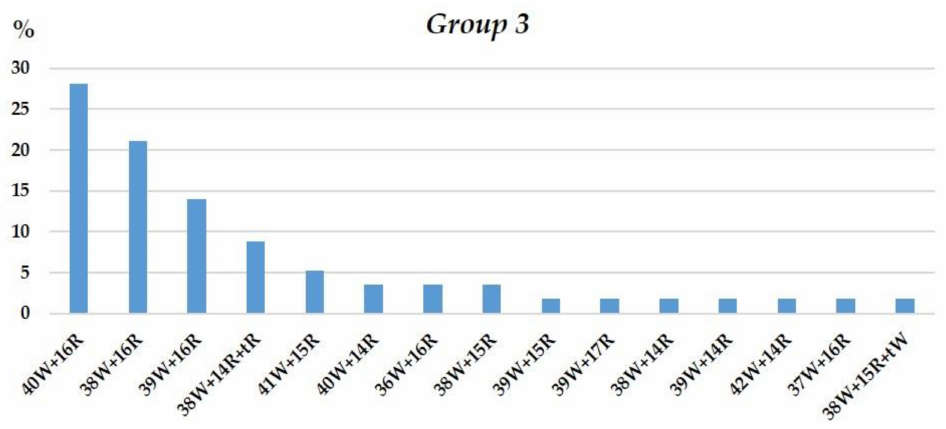
Figure 11. Frequencies of different chromosome sets in plant karyotypes of Group 3. Designations follow Figure